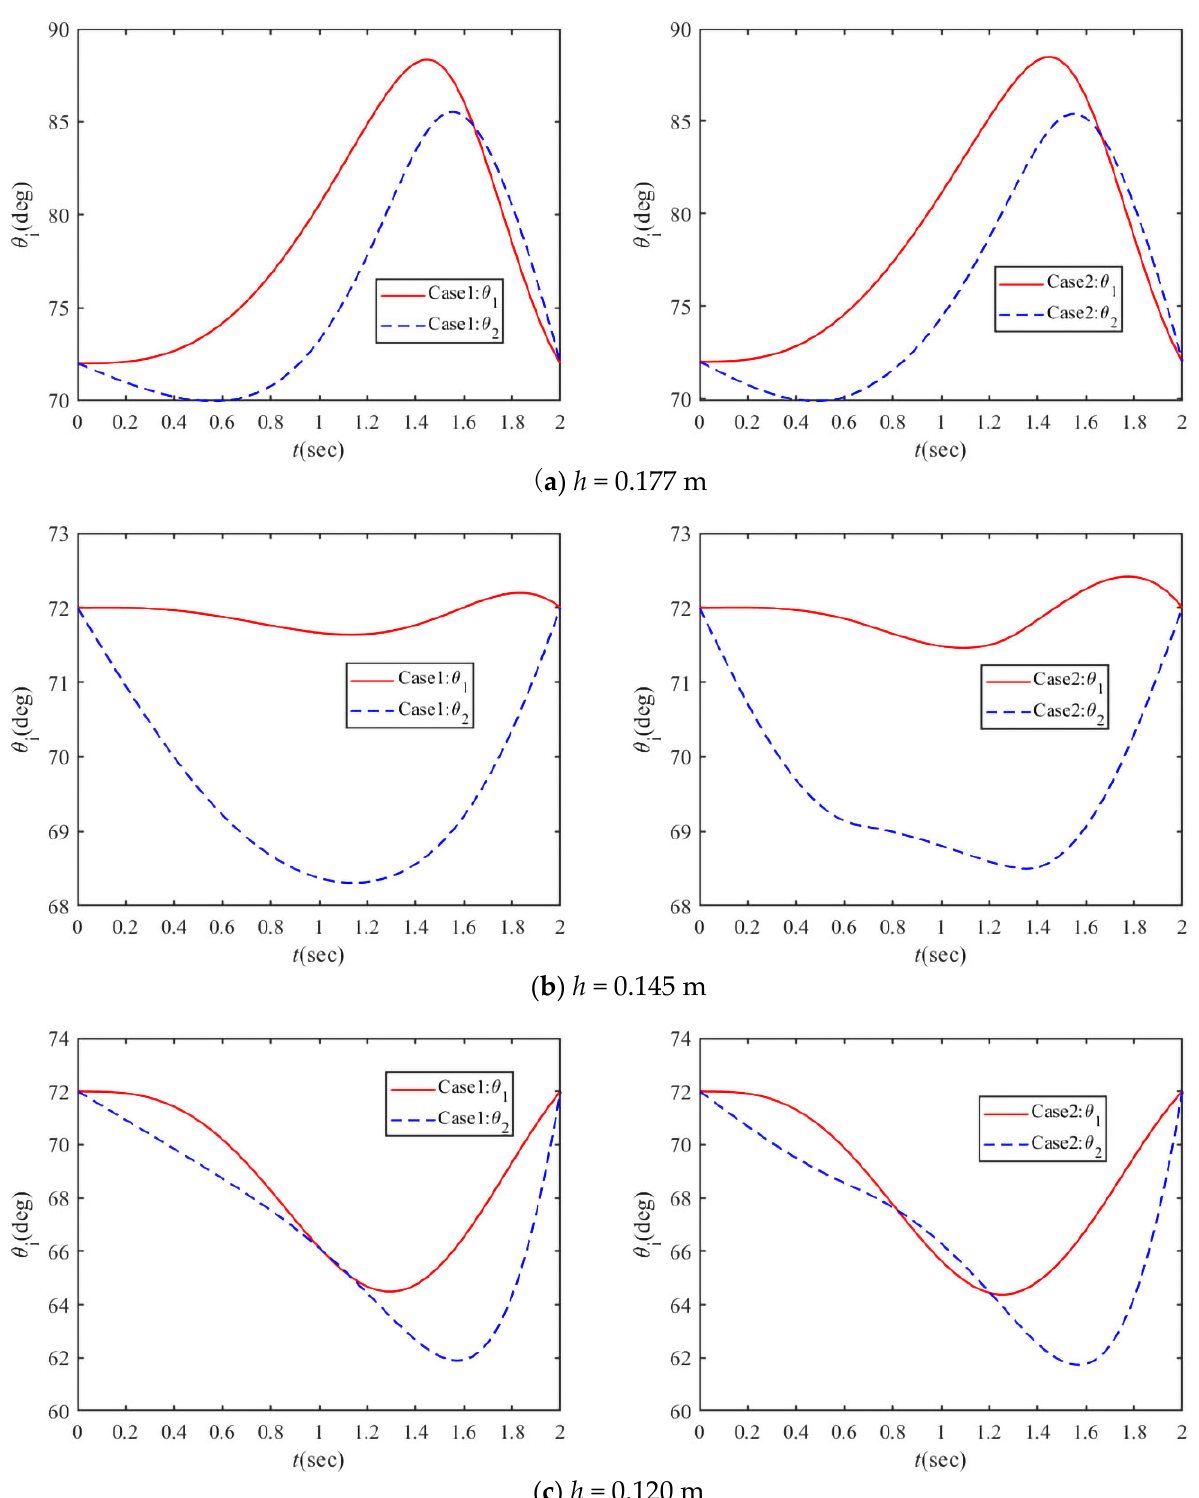
Figure 13. The angular displacement of the active joint when choosing the via points with different heights h .